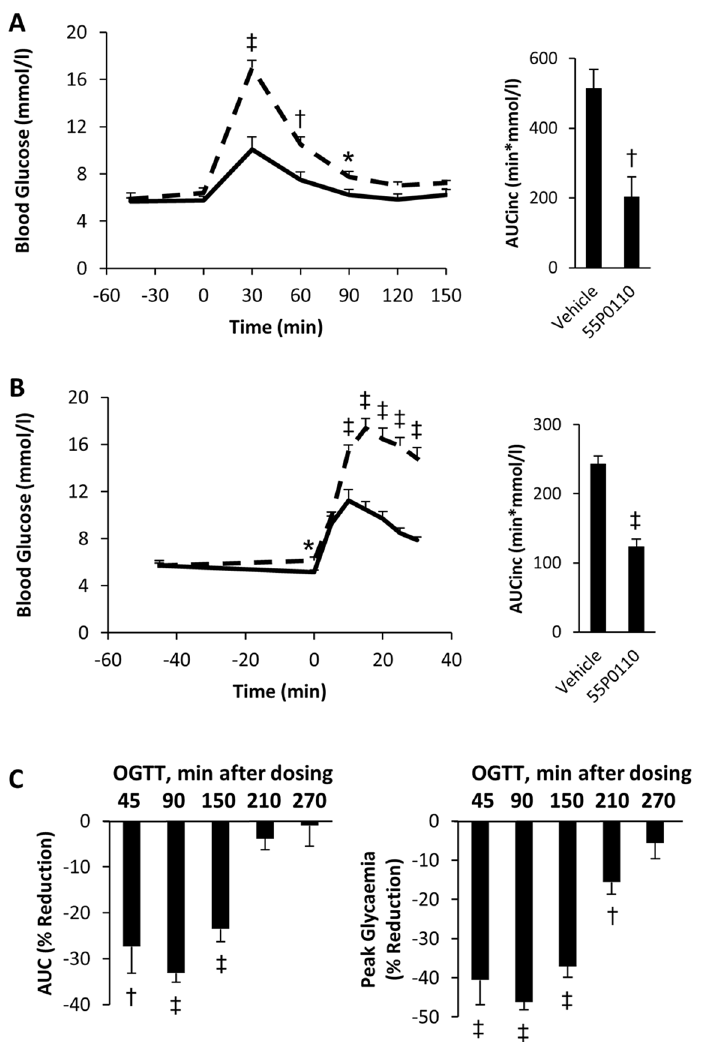
Fig 3. Improvement of glucose tolerance by a single oral dose of 55P0110 in mice. Effects of oral administration of 90 mg/kg 55P0110 (full lines) or vehicle (broken lines) 45 min before starting a glucose tolerance test in male C57BL/6J mice. ( A ) Glucose curve and incremental area under the glucose curve (AUCinc) in the standard oral glucose tolerance test. ( B ) Glucose excursion and AUCinc during the initial 30 min after glucose administration. ( C ) Reductions of total areas under the curves (AUC; left bar graph) and peak blood glucose (30 min after glucose administration; right bar graph) at different time intervals after the administration of 55P0110 (data given in % of mean of the corresponding vehicle treated control group). Means ± SEM; n = 8 – 9 each; * p < 0.05; † p < 0.01; ‡ p < 0.001 vs. vehicle.